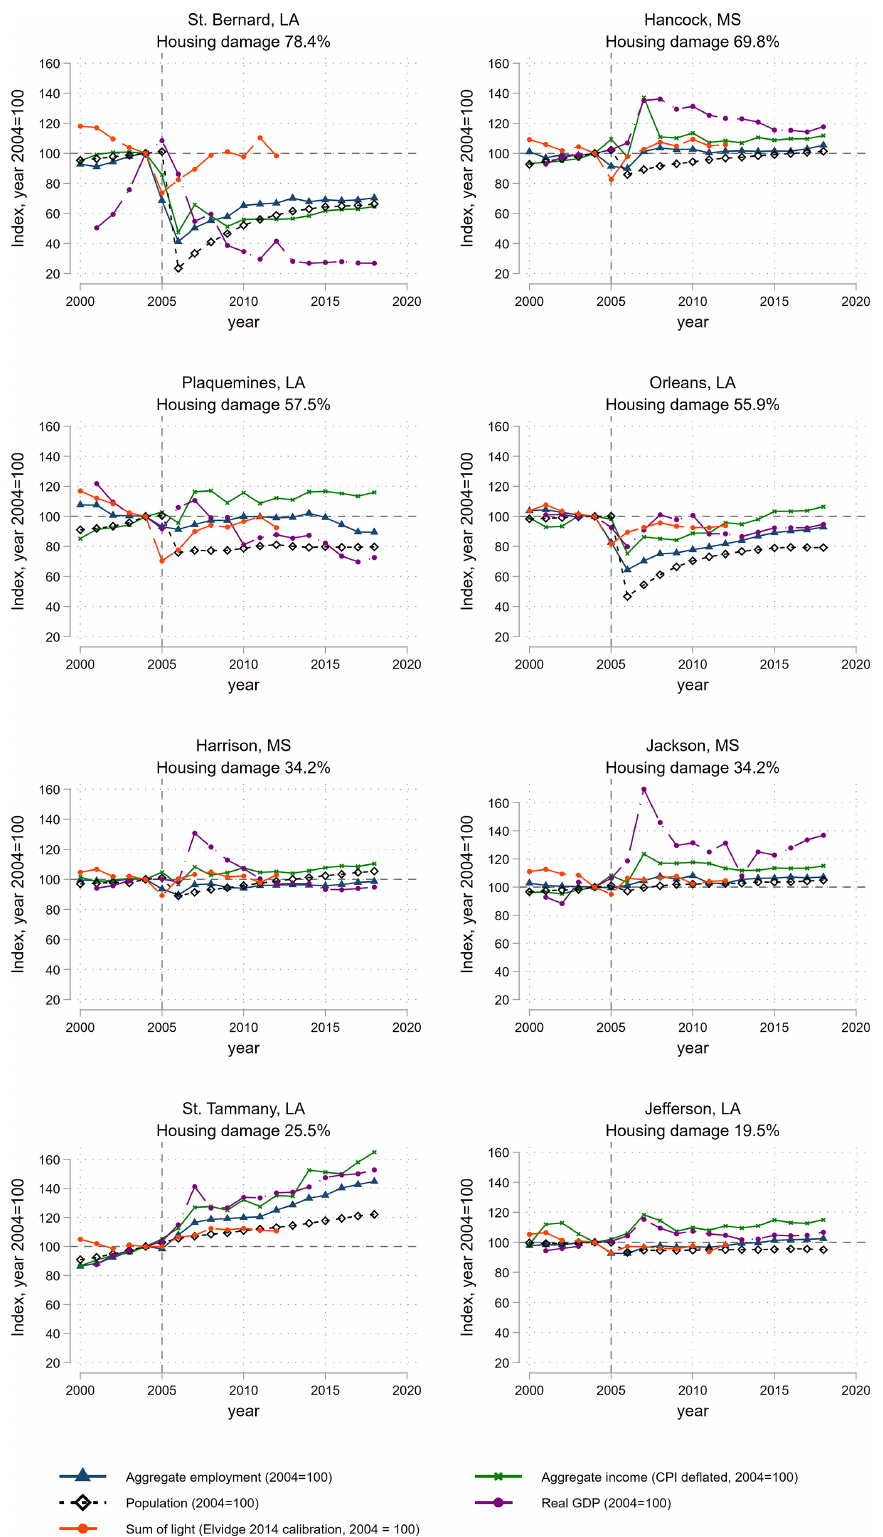
Figure 7. Night light and economic indicators following Katrina for the eight most-affected counties. Based on own calculations. All variables are indexed with 2004 = 100. Aggregate employment, income, population, and real GDP data come from the U.S. Burea of Econonomic Analysis (2020). Night lights are calibrated using the Elvidge et al. (2014)